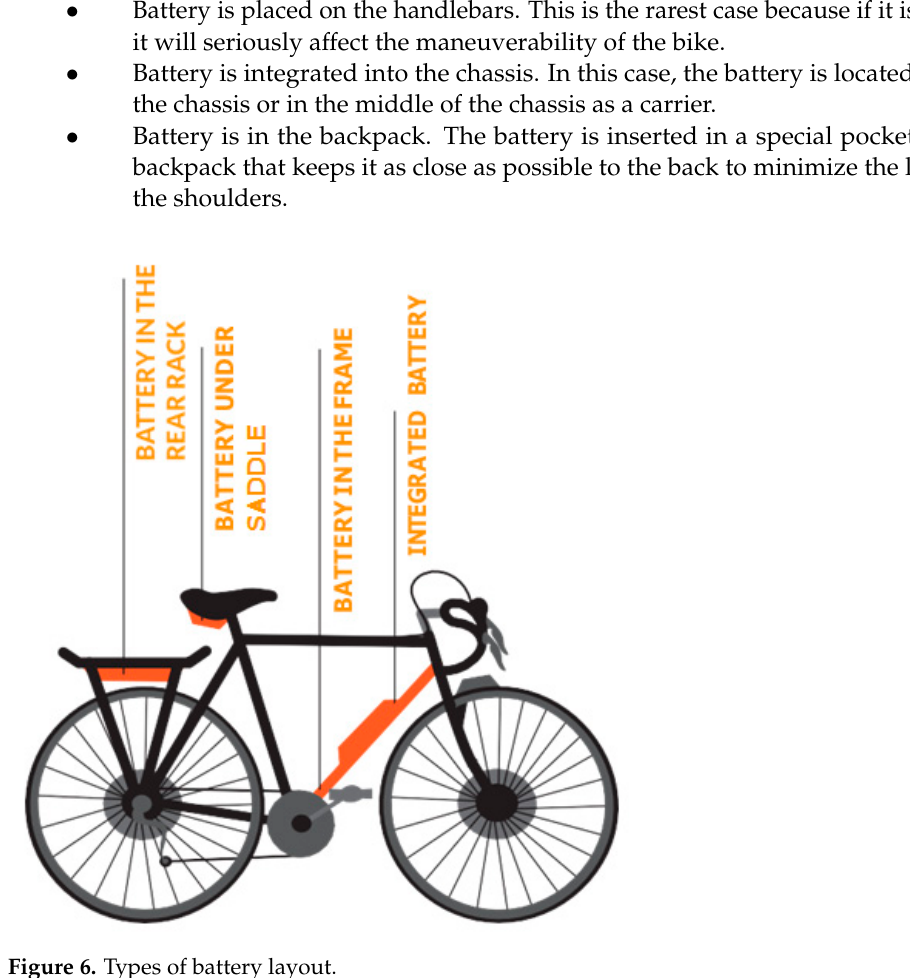
Figure 6. Types of battery layout.